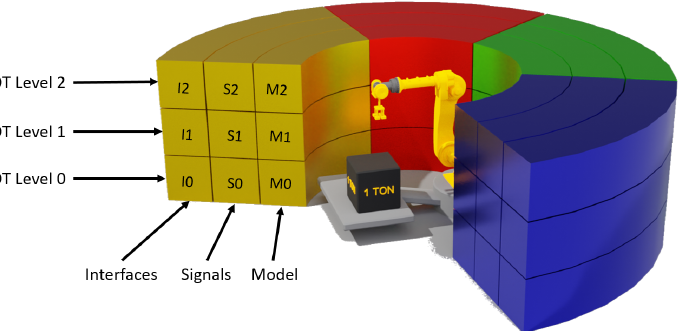
Figure 7. 3D visualization of the generic paradigm for architecting digital twins. [Source: Own